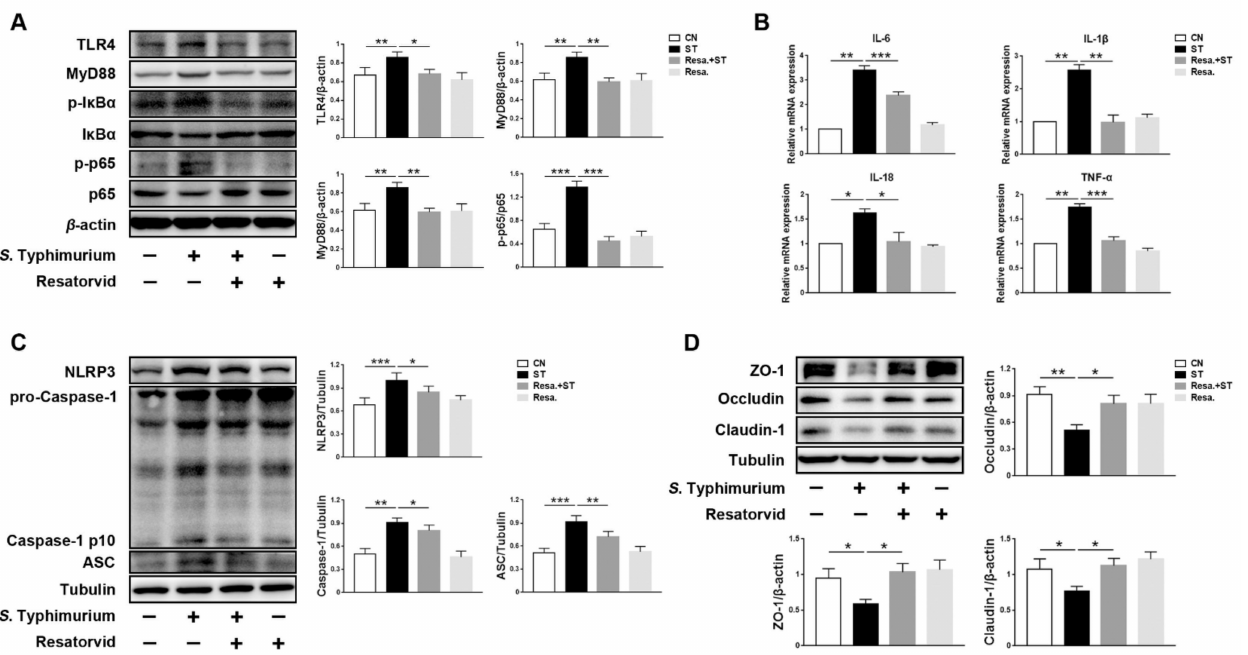
Figure 5. L. johnsonii L531 inhibits S. Typhimurium-induced activation of TLR4 pathway to maintain tight junctions. ( A ) Western blotting of TLR4, MyD88, p-I κ B α , I κ B α , p-p65, and p65. ( B ) Pro-inflammatory cytokines mRNA expression levels in IPEC-J2 cells were detected by qRT-PCR. ( C ) Western blotting of NLRP3, ASC, Caspase-1. ( D ) Western blotting of ZO-1, Occludin, Claudin-1. CN (Control), ST ( S. Typhimurium), Resa. (Resatorvid). The panels show proteins or cytokines quantification using ImageJ software (version 1.50). The values are shown as the mean ± SEM; n = 3. * p < 0.05, ** p < 0.01, *** p < 0.001.